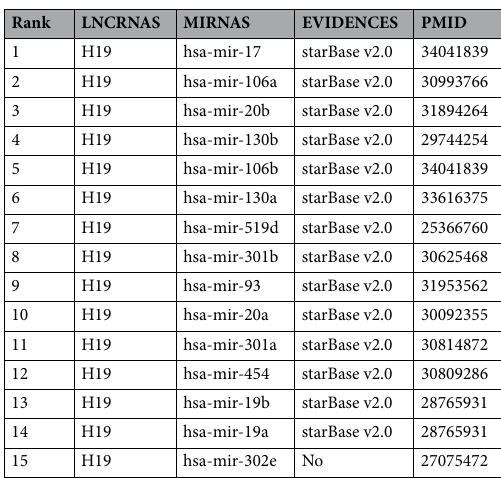
Table 6. The top 15 candidate miRNAs for H19.